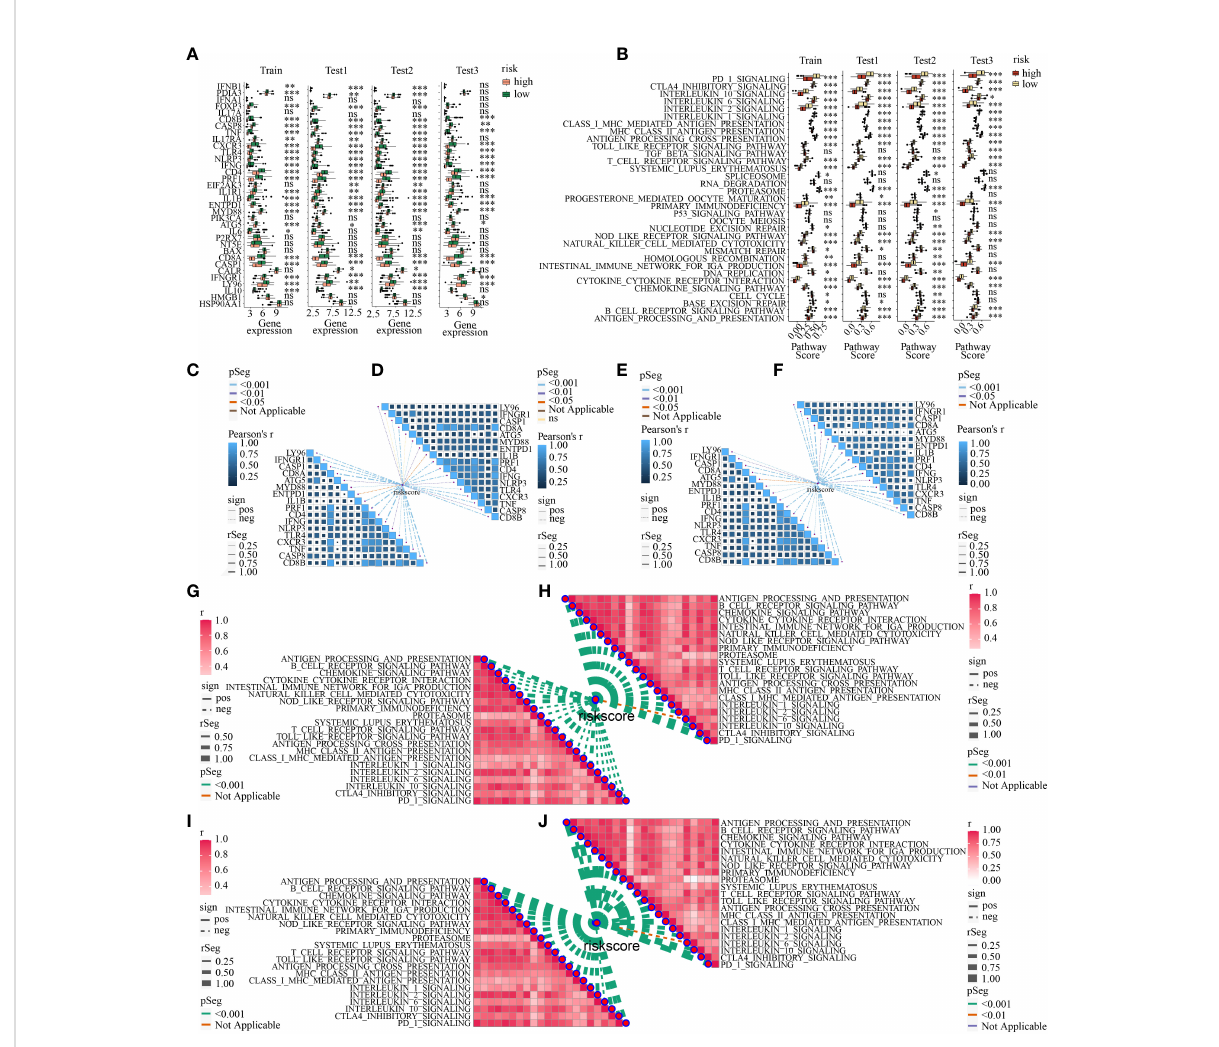
FIGURE 11 (A) The discrepancy of the expression levels of ICD-related genes in high- and low-risk subpopulations in train, test1, test2, and test3; (B) The discrepancy of the activity of the immune-related pathways in two risk subpopulations in train, test1, test2, and test3; The correlation between ICDRS-based risk score and the expression of ICD-related genes in train (C) , test1 (D) , test2 (E) , and test3 (F) ; The correlation between ICDRS- based risk score and immune-related pathway scores in train (C) , test1 (D) , test2 (E) , and test3 (F) . The correlation between ICDRSbased risk score and immune-related pathway scores in train (G) , test1 (H) , test2 (I) , and test3 (J) . (* indicates p <0.05; ** indicates p < 0.01; *** indicates p < 0.001; ns: